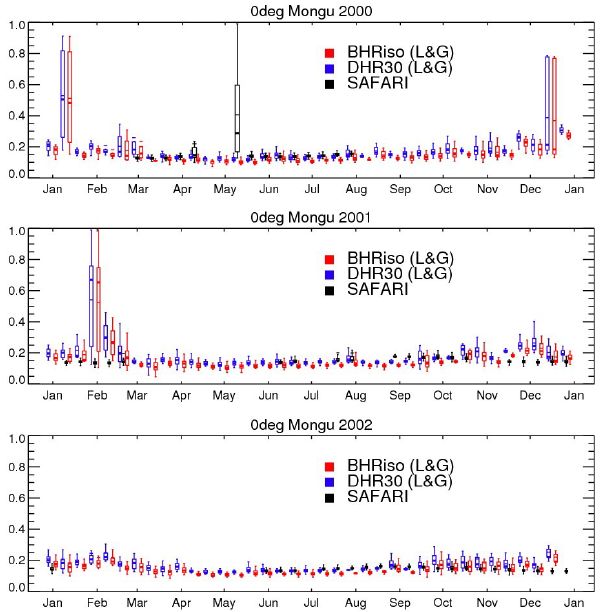
Figure 8. Comparison of MSA vs. in situ albedo observations for the 0DEG mission. The box-and-whisker diagrams represent the spatial variability of the MSA retrievals within a 3 × 3 window cen- tred at Mongu (Zambia). For the in situ observations (black), the diagrams represent the temporal variability within a 10-day obser- vation